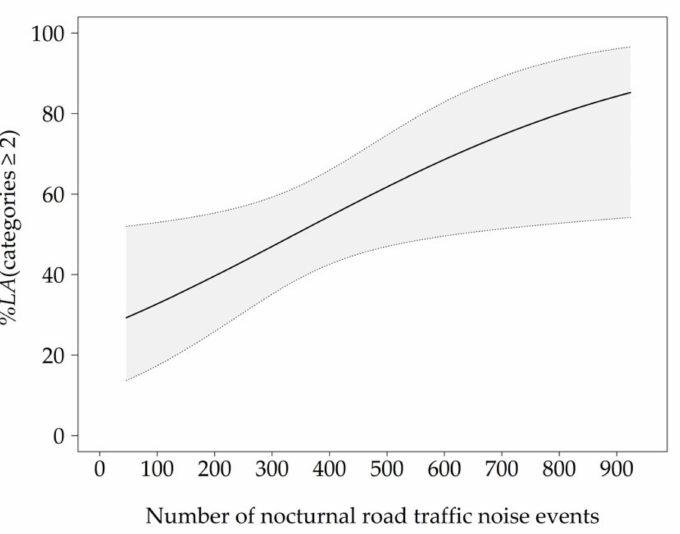
Figure 3. Exposure–response curve for the probability to be annoyed at least a little ( %LA ) due to the number of nocturnal road traffic noise events adjusted for the participants’ subjective assessment of road transport (median = 9). The grey area represents the 95% confidence